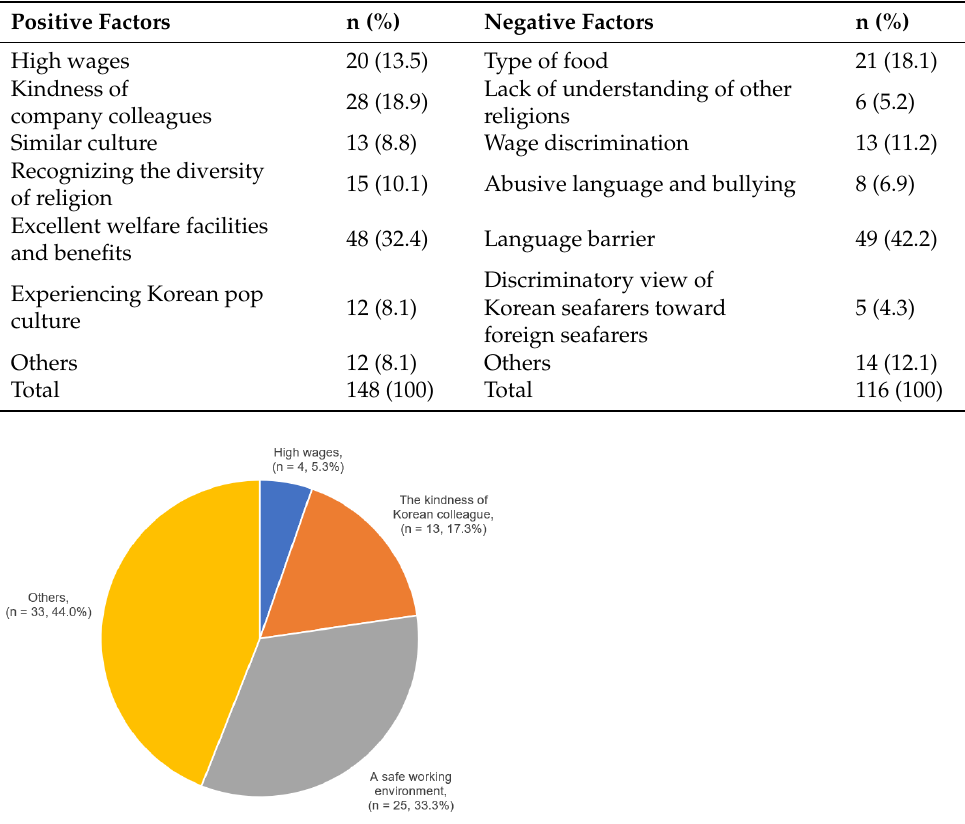
Table 5. Positive and negative factors related to working with Korean seafarers (multiple choices).